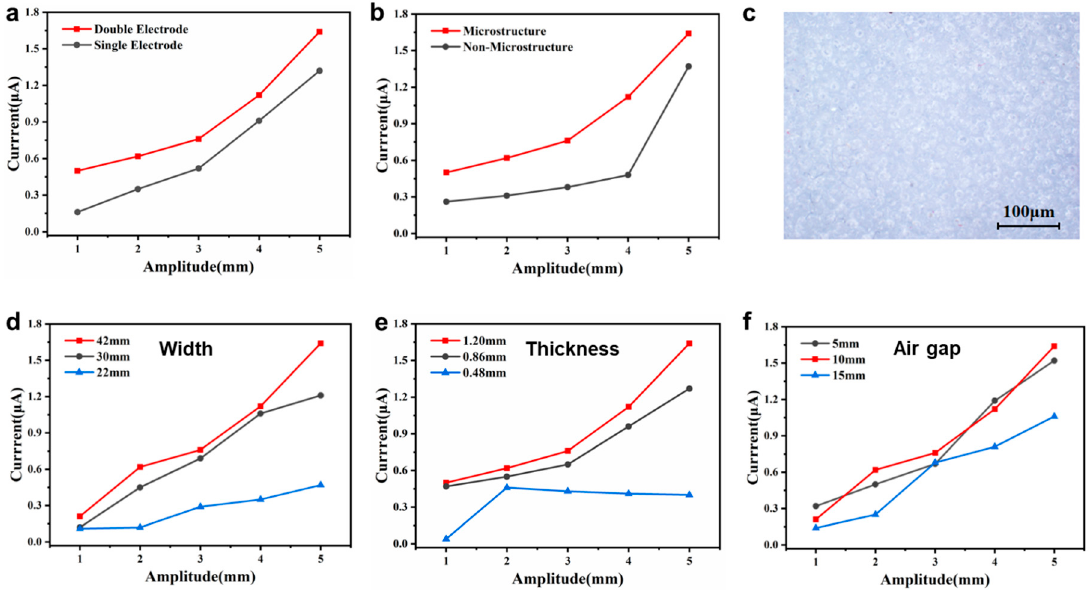
Figure 3. The impacts of different working modes and parameters on the output performance of the SRS-TENG. Current performance comparison between the SRS-TENGs ( a ) working at double electrode and single electrode modes, and ( b ) with or without surface treatment of the strip. ( c ) Surface microstructure of silicone rubber polished by sandpaper. ( d ) Current performance comparison among the SRS-TENGs with different widths of 22, 30, and 42 mm, ( e ) different thicknesses of 0.48, 0.86, and 1.2 mm, and ( f ) different air gaps of 5, 10 and 15